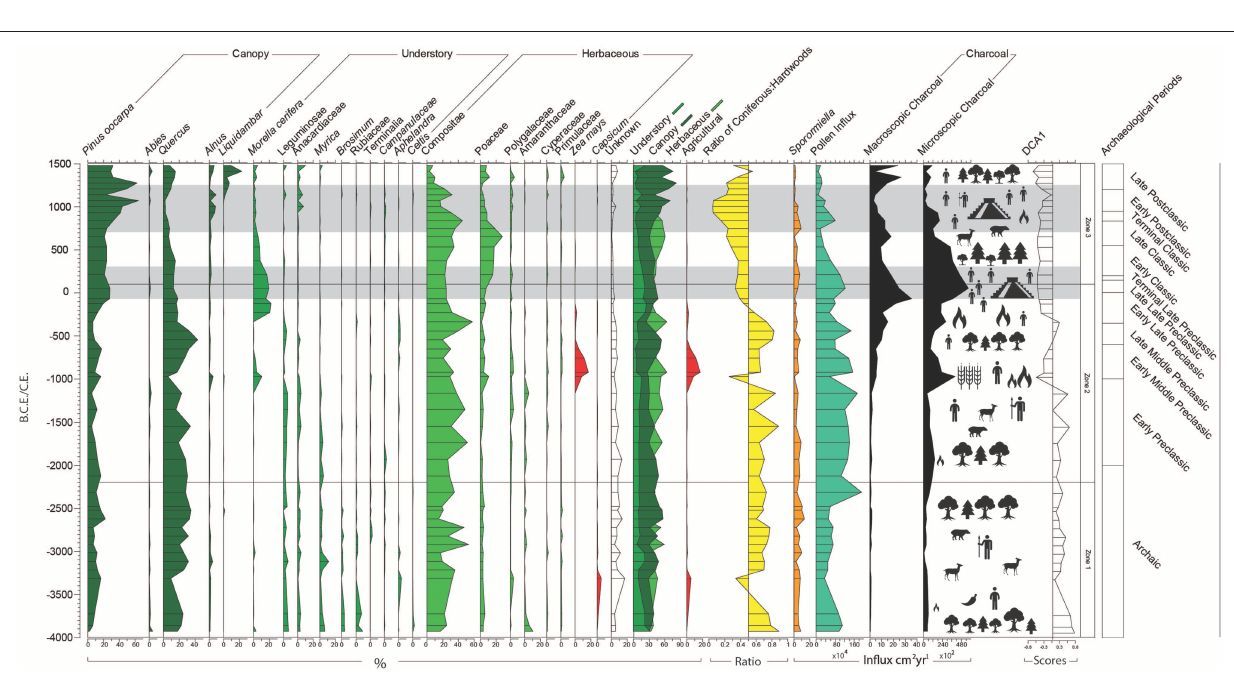
Zone 1 (545.75–421 cm, 14 samples, 4000–2200B.C.E.)